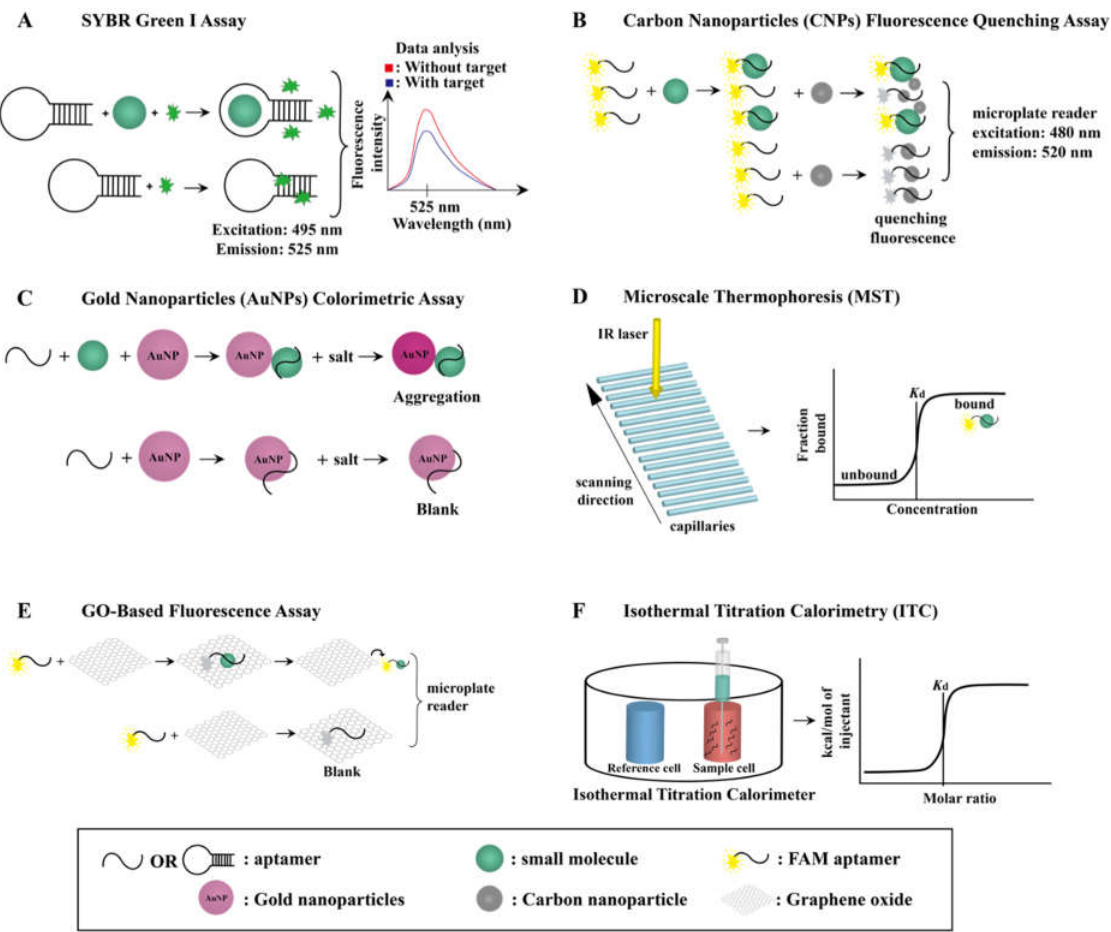
Figure 2. A schematic illustration of six commonly used methods for detecting interactions between small molecule and aptamer. ( A ) SYBR green I (SGI) assay. ( B ) Carbon nanoparticles (CNPs) fluorescence quenching assay. ( C ) Gold nanoparticles (AuNPs) colorimetric assay. ( D ) Microscale thermophoresis (MST) assay. ( E ) Graphene oxide (GO)-based fluorescent assay. ( F ) Isothermal titration calorimetry (ITC)